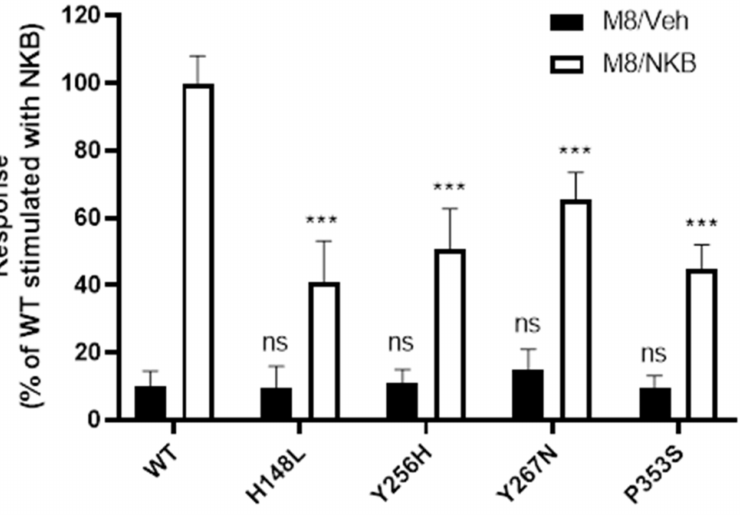
Figure 6. M8-mediated trafficking of intracellularly located NK3R mutants to the cell membrane restores NKB-mediated stimulation of inositol phosphate accumulation. Receptor signalling was measured